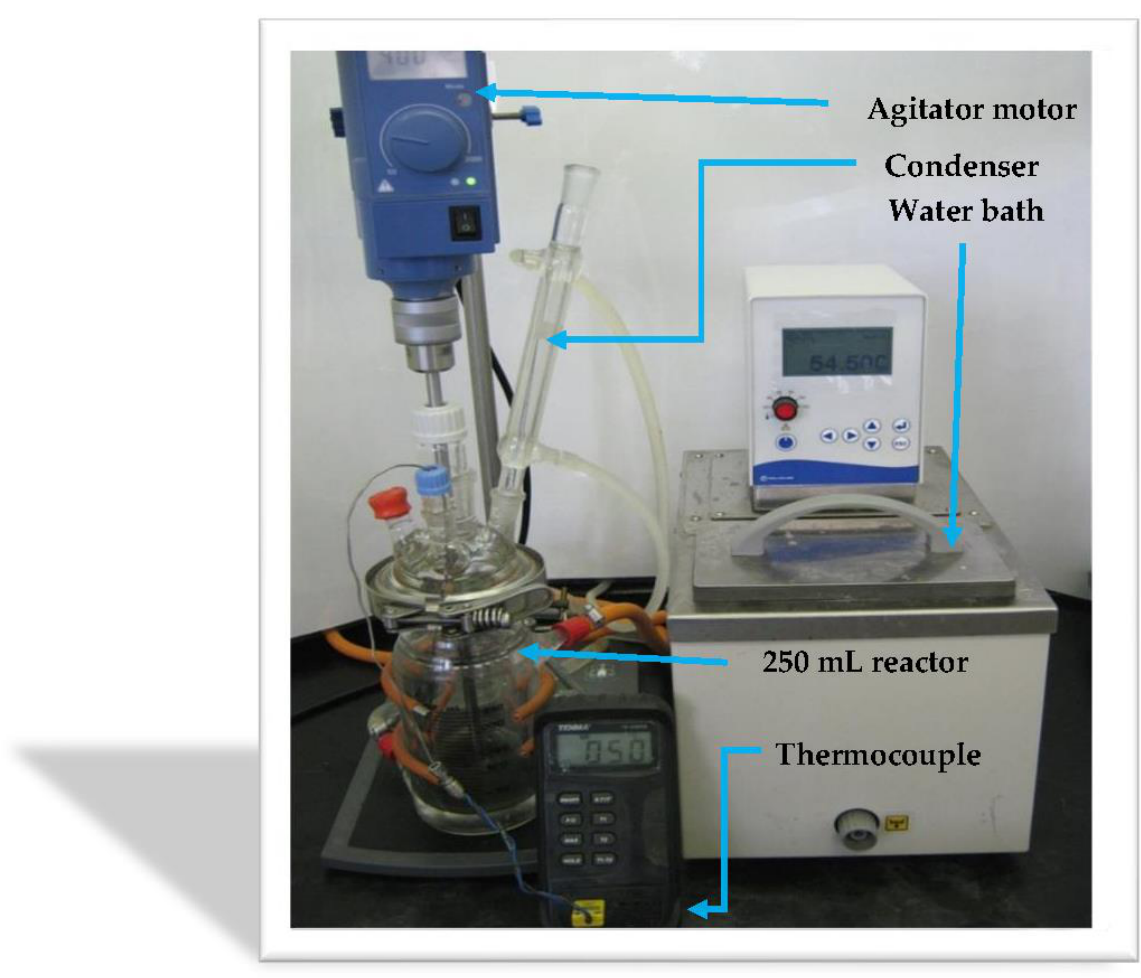
Figure 1. Experimental set-up of batch epoxidation studies.